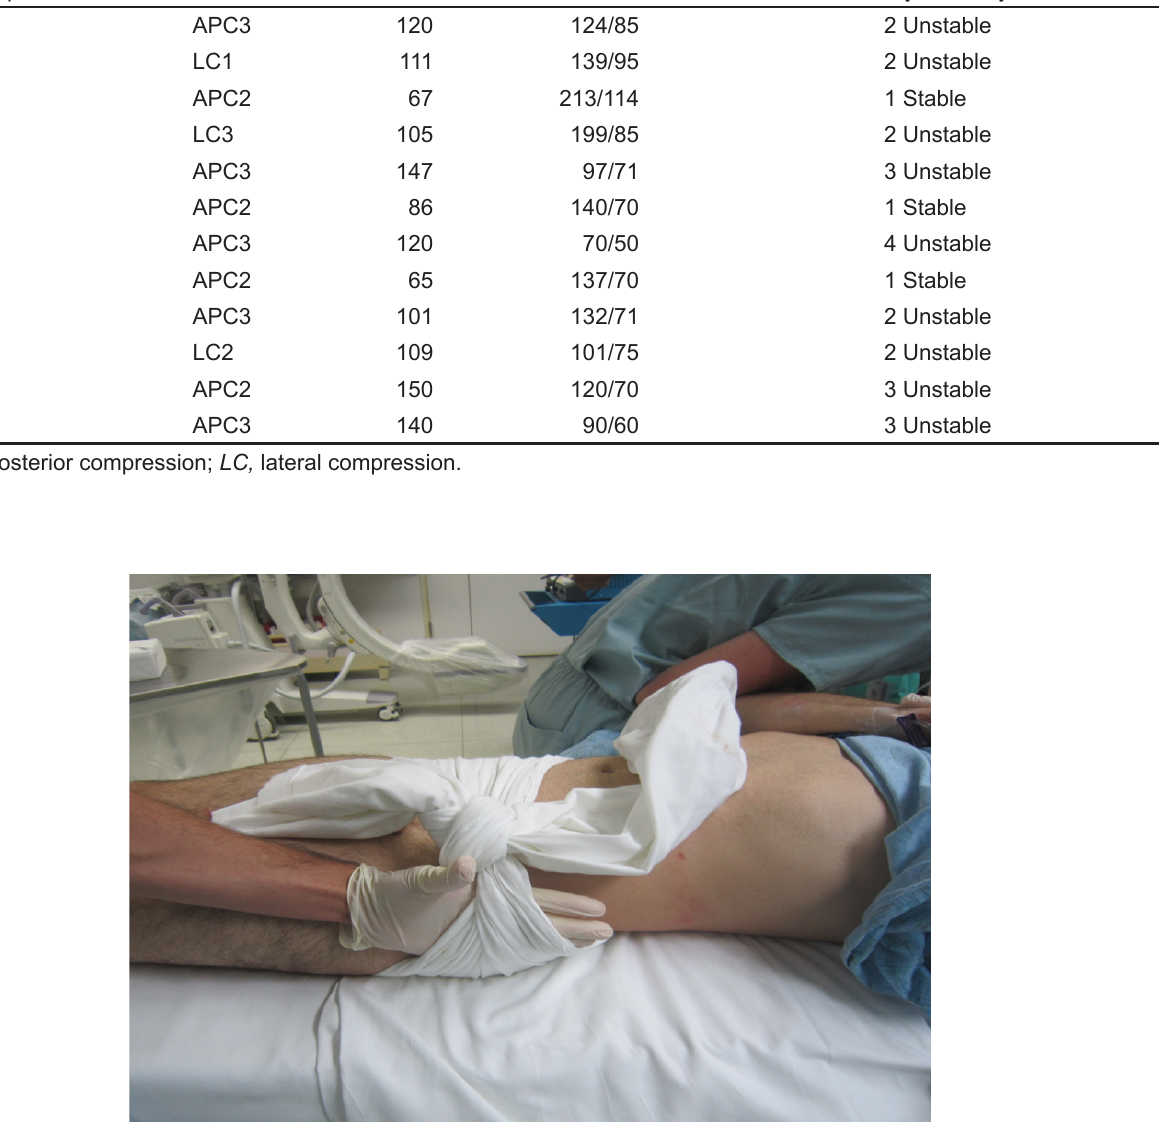
Figure 3. Poorly applied pelvic circumferential compression device: too loose, too low and should not be